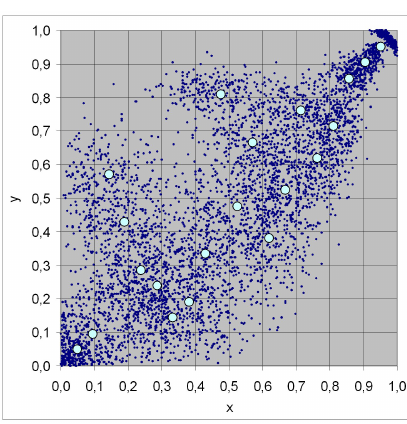
Figure 19: "Worst case" negative binomial copula, a = b = 15